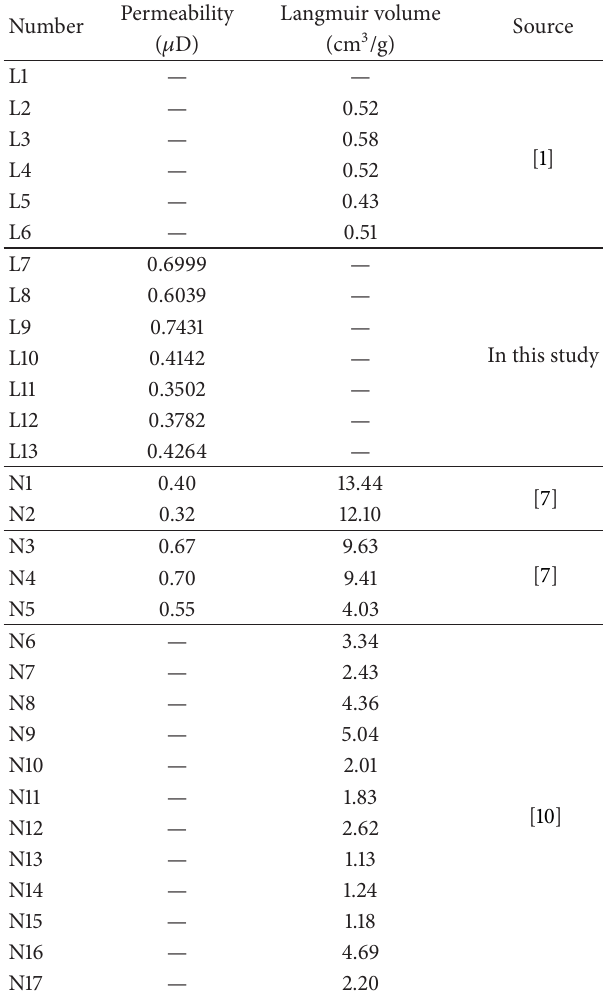
Table 3: Permeability and methane adsorption results for some shale